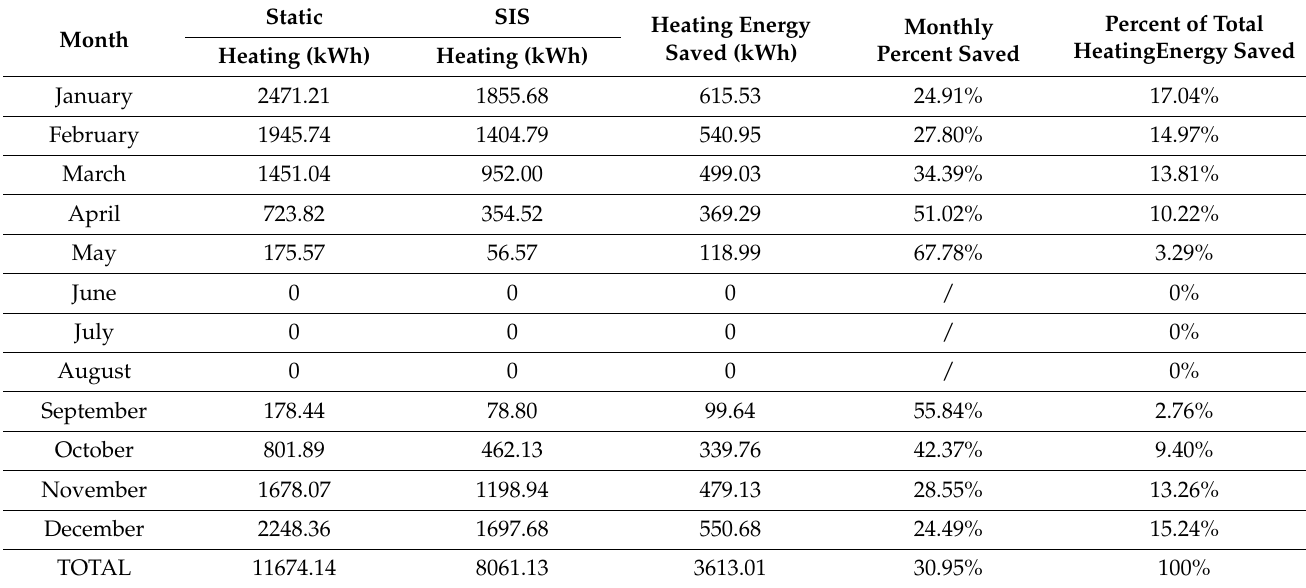
Figure 10. R-value and surface temperature variations using the simple rule set for SIS south window during the cooling season. For SIS windows, high R-value = 1.1 m 2 · K/W; low R-value = 0.45 m 2 · K/W; high SHGC = 0.4; low SHGC = 0.1. Table 6. Comparison of heating energy consumption for static and dynamic windows for the prototypical detached